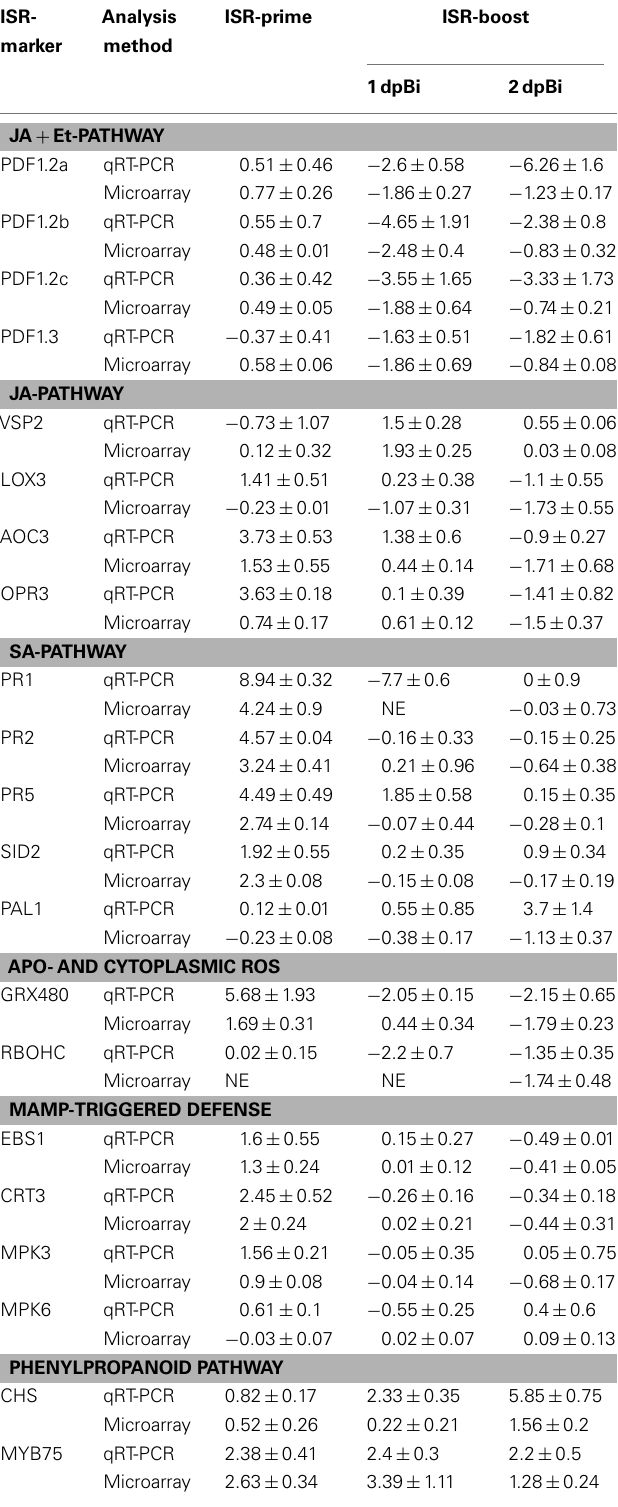
Table 3 | Comparison between the results of the microarrays (shown as log 2 ratio) and the qRT-PCR (shown as log 2 ratio) for various